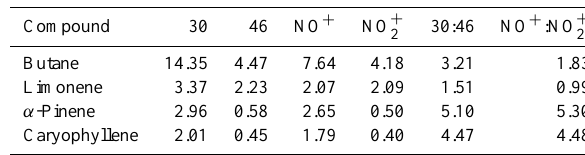
Table 2. Contributions (%) to the HR-AMS mass spectra of each of the standards (columns 1–4), and ratios of these peak heights (columns 5, 6). 30 and 46 are all of the signal at these UMR peaks. NO + and NO + are determined in the HR analysis. Stated AMS 2 atomic ratios are without using correction factors for non-uniform detection of C, H, N, and